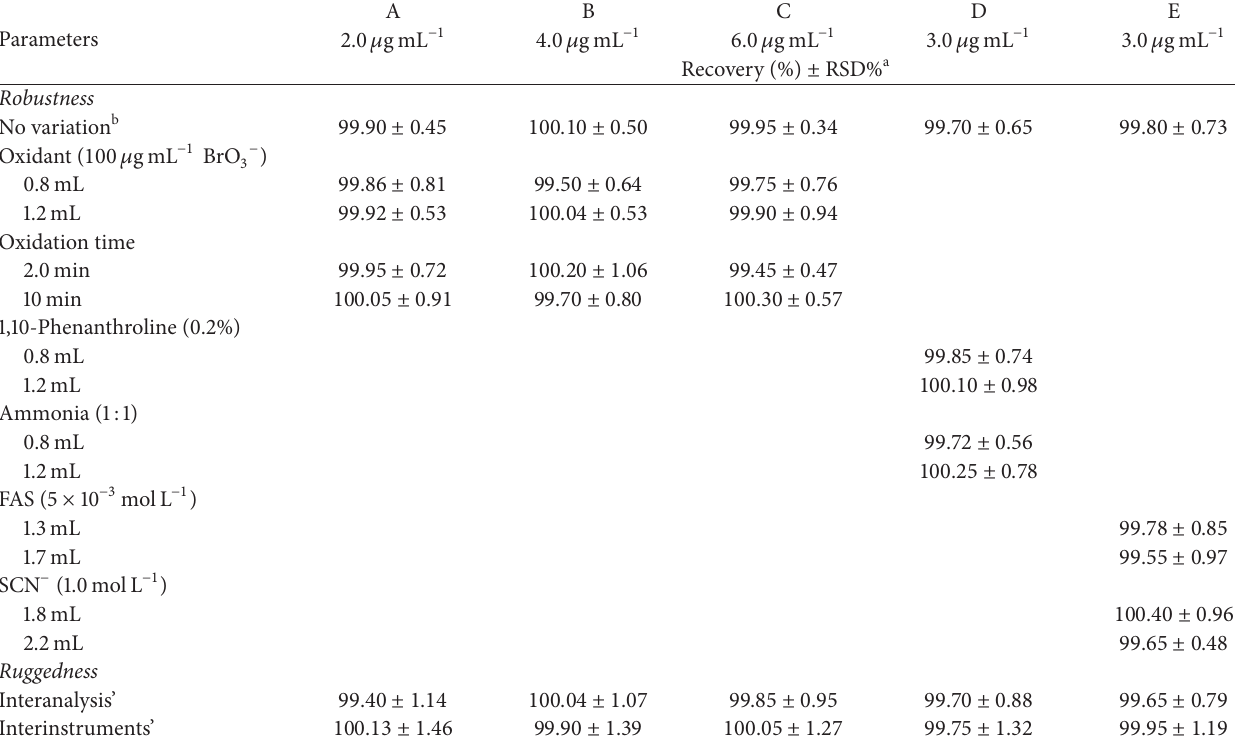
Table 5: Robustness and ruggedness of the proposed methods.